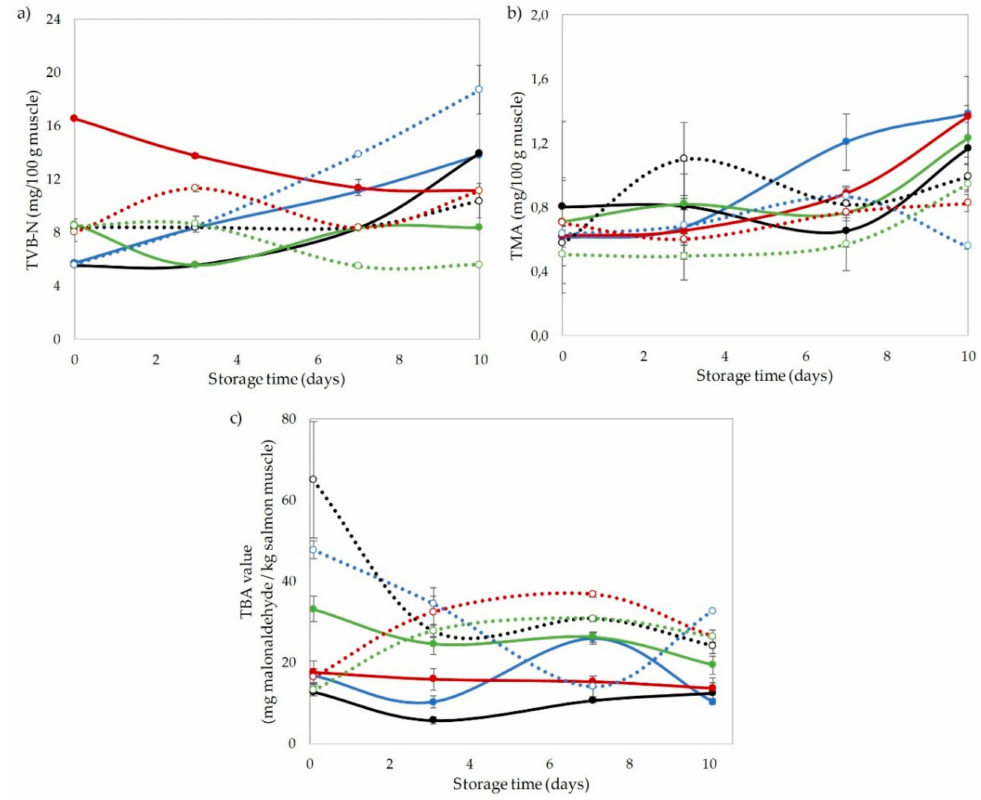
Figure 1. E ff ect of treatment and refrigerated storage time on ( a ) total volatile basic nitrogen (TVB-N), ( b ) trimethylamine (TMA), and ( c ) thiobarbituric acid (TBA) index for coho salmon fillets. Di ff erent lowercase letters indicate significant di ff erences among treatments ( p < 0.05). Di ff erent uppercase letters indicate significant ( p < 0.05) di ff erences among days of storage. ( • ) 0 MPa / 0% CO 2 ; ( • ) 0 MPa /